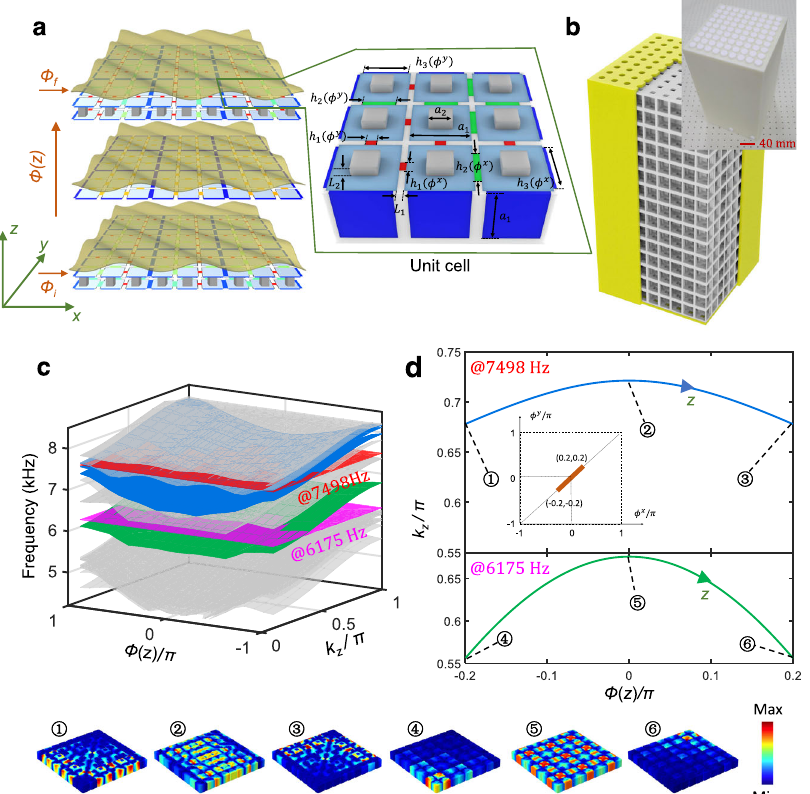
Fig. 2 3D channel-modulated acoustic crystal and its dispersion property. a Schematic of the 3D channel-modulated acoustic crystal and its unit cell. b Photograph of the printed 3D channel-modulated sample. c Dispersion diagram of a supercell composed of 9 ´ 9 coupled cavities, terminated by a hard- wall boundary along x and y directions, and a periodic boundary condition along the z -direction. Bulk modes are shown in gray, topological pumping of edge and corner modes are in blue and green, respectively. d Wave number k z as a function of the pumping parameter for fi xed frequencies f ¼ 7498Hz (upper panel) and f ¼ 6175Hz (lower panel), corresponding to the cross-section illustrated by the red and purple planes in c . The inset in the upper panel shows the diagonal orbit with the phason value from ð(cid:4) 0 : 2 π ; (cid:4) 0 : 2 π Þ to ð 0 : 2 π ; 0 : 2 π Þ . The insets below c and d show representative mode shapes for each type of mode. The color scale corresponds to the pressure